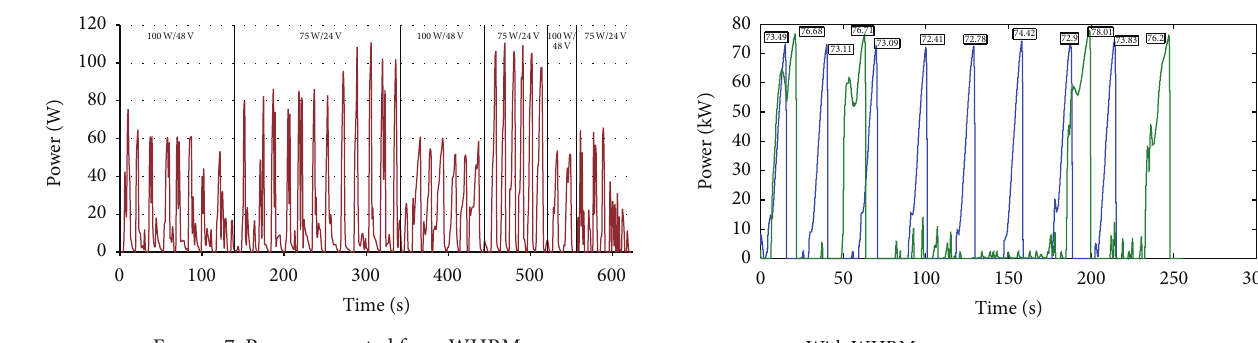
Figure 7: Power generated from WHRM.